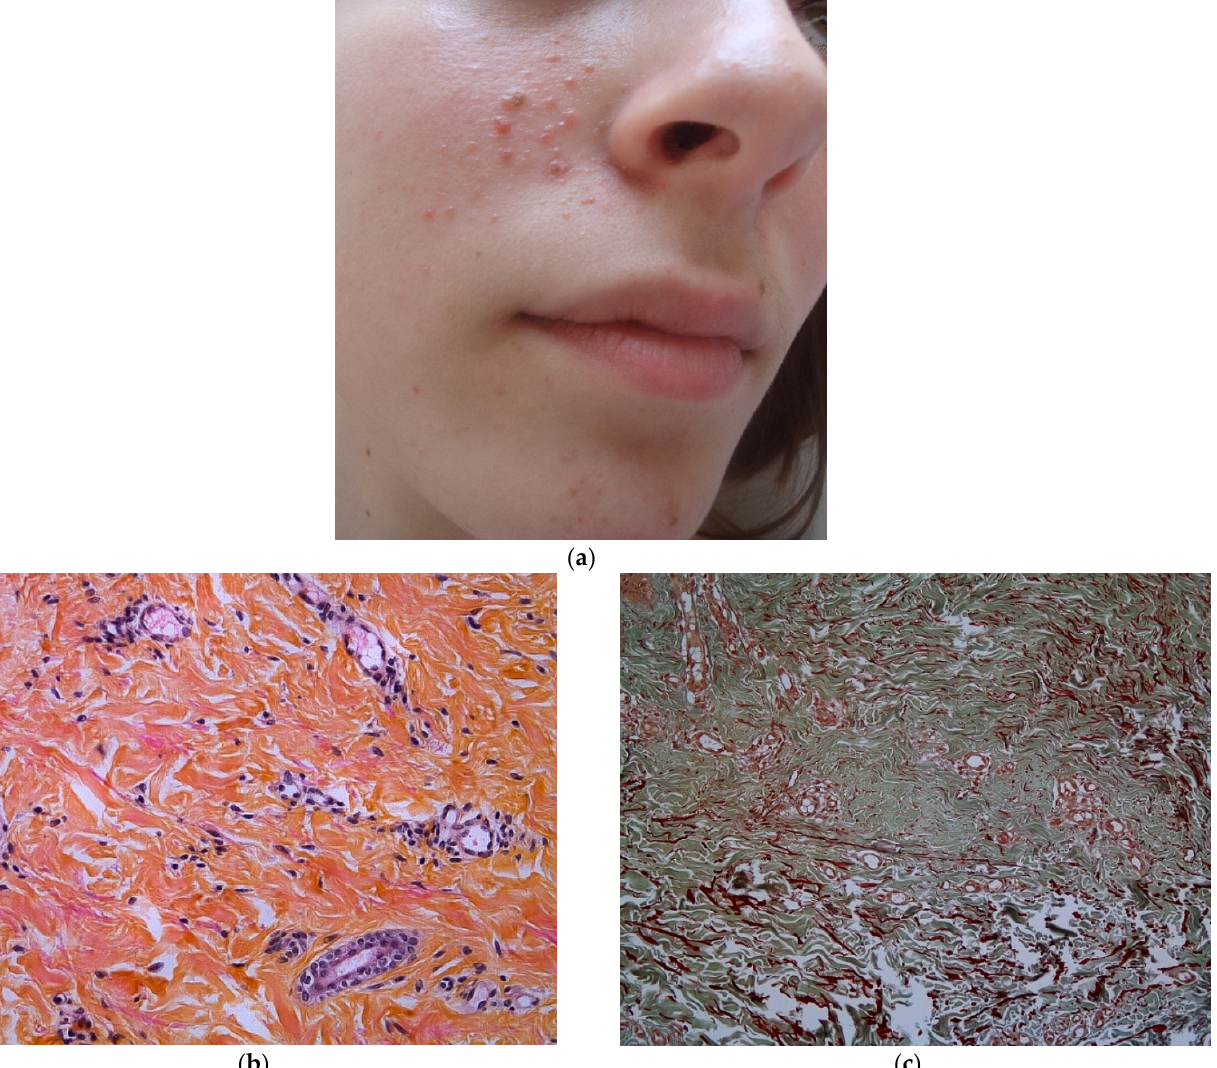
Figure 2. Angiofibroma. ( a ) Face’s angiofibromas in a 14 year-old patient; ( b ) Hematein eosin ×40: hypertrophy of the collagen bundles and of the vascular elements represented by dilated venules; ( c ). Orcein staining ×40: decreased and fragmented elastic fibers.